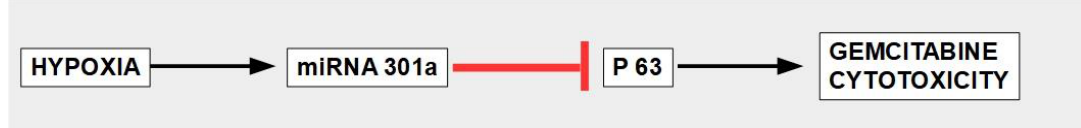
Figure 11. Mechanism of hypoxia-inducedgemcitabine resistance.